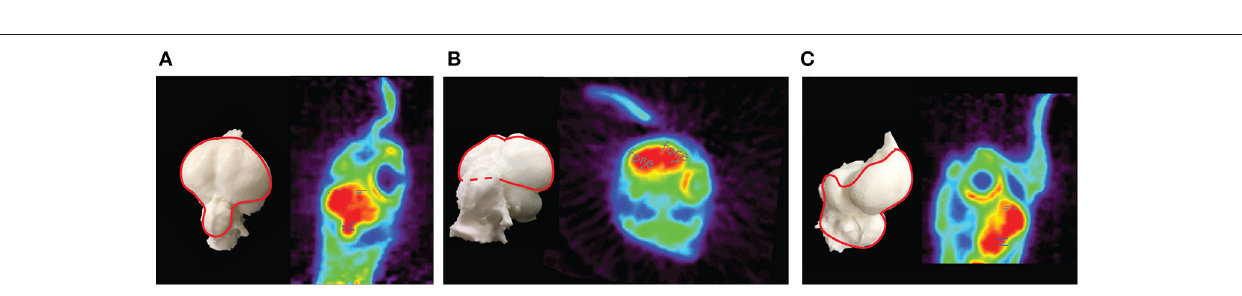
FIGURE 4 | PET images of the rat brain. Depicted are (A) a horizontal slice through the brain showing the striatum ROI, (B) a sagittal slice showing the motor cortex ROI on top (purple dashes), hippocampus ROI in the center (blue dashes), and cerebellum ROI at the bottom (white dashes), and (C) a coronal slice showing the hippocampus (blue circles) and amygdala ROIs (pink circles).